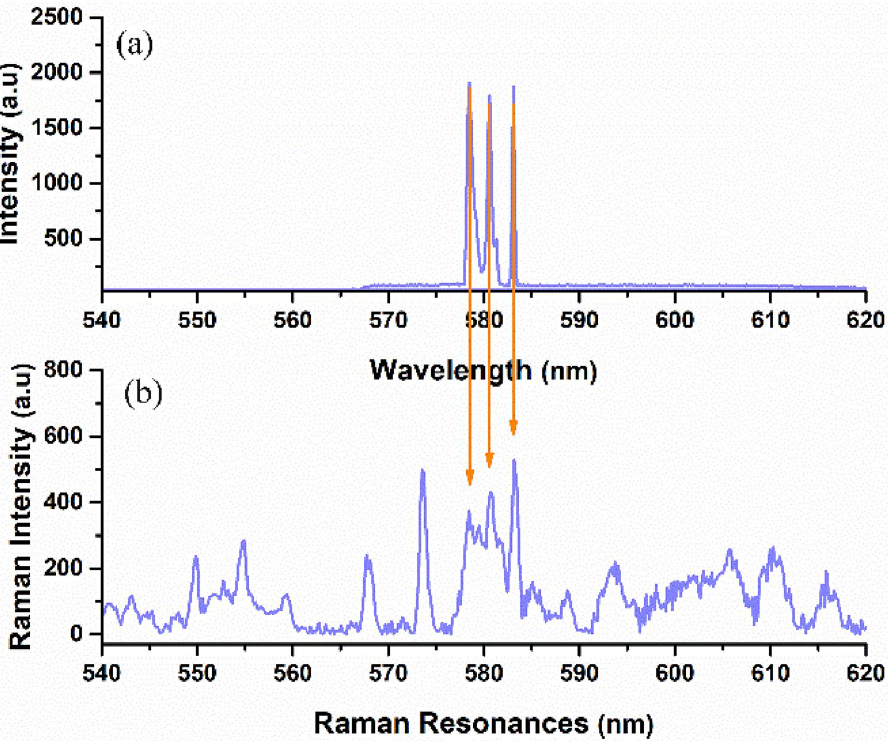
Figure 5. ( a ) Emission spectrum from Rhodamine 6G containing ZnO microspheres at 109 mJ/pulse pump energy. ( b ) The Raman spectrum of pure Rhodamine 6G dye. The arrows show the correspondence of the emission spectrum of Rhodamine 6G dye-containing ZnO microspheres and the Raman signals of pure Rhodamine 6G dye.